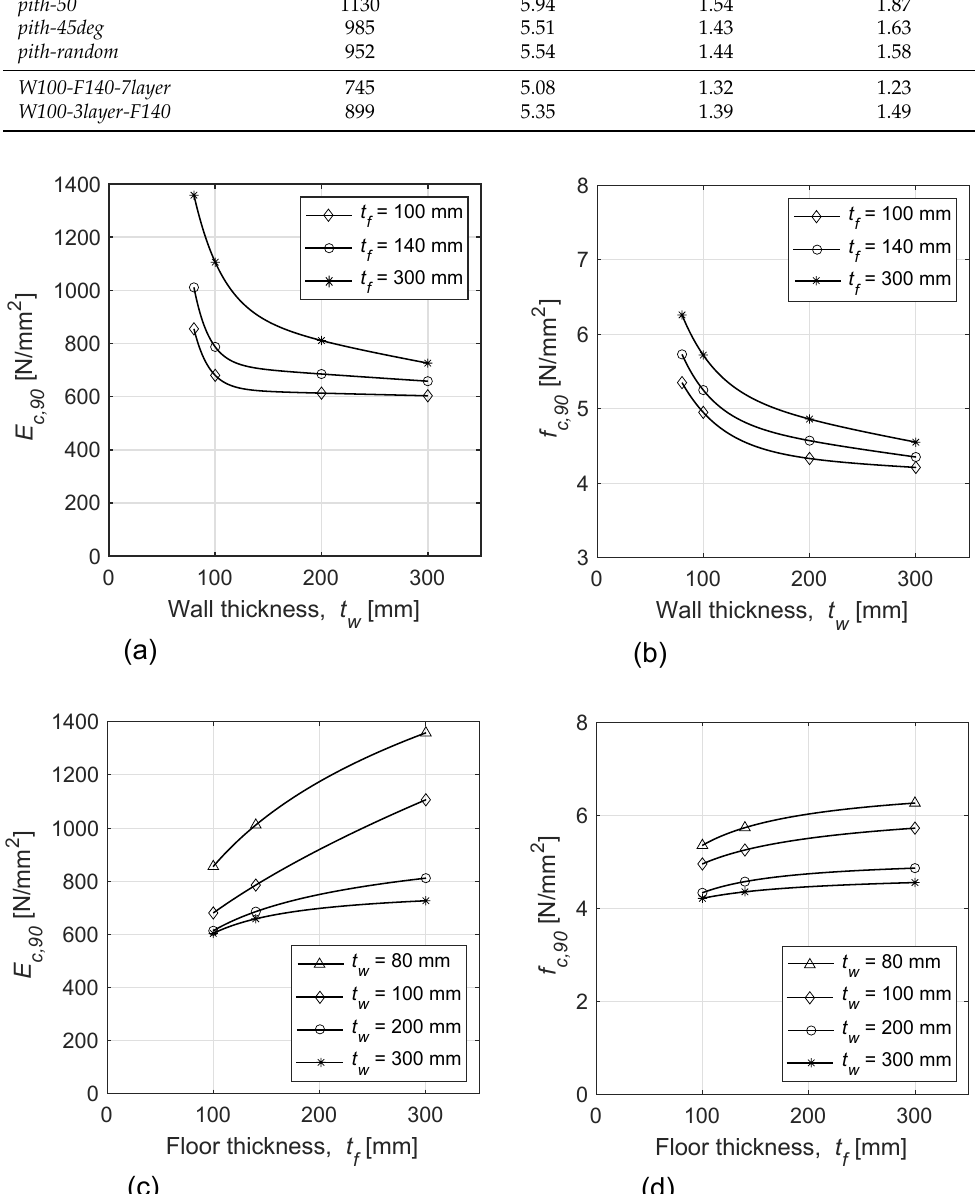
Figure 12. Influence of floor and wall thickness on connection stiffness, E c ,90 , and strength, f c ,90 ; ( a ) E c ,90 and ( b ) f c ,90 as a function of wall thickness, t w ; ( c ) E c ,90 and ( d ) f c ,90 as a function of floor thickness, t f